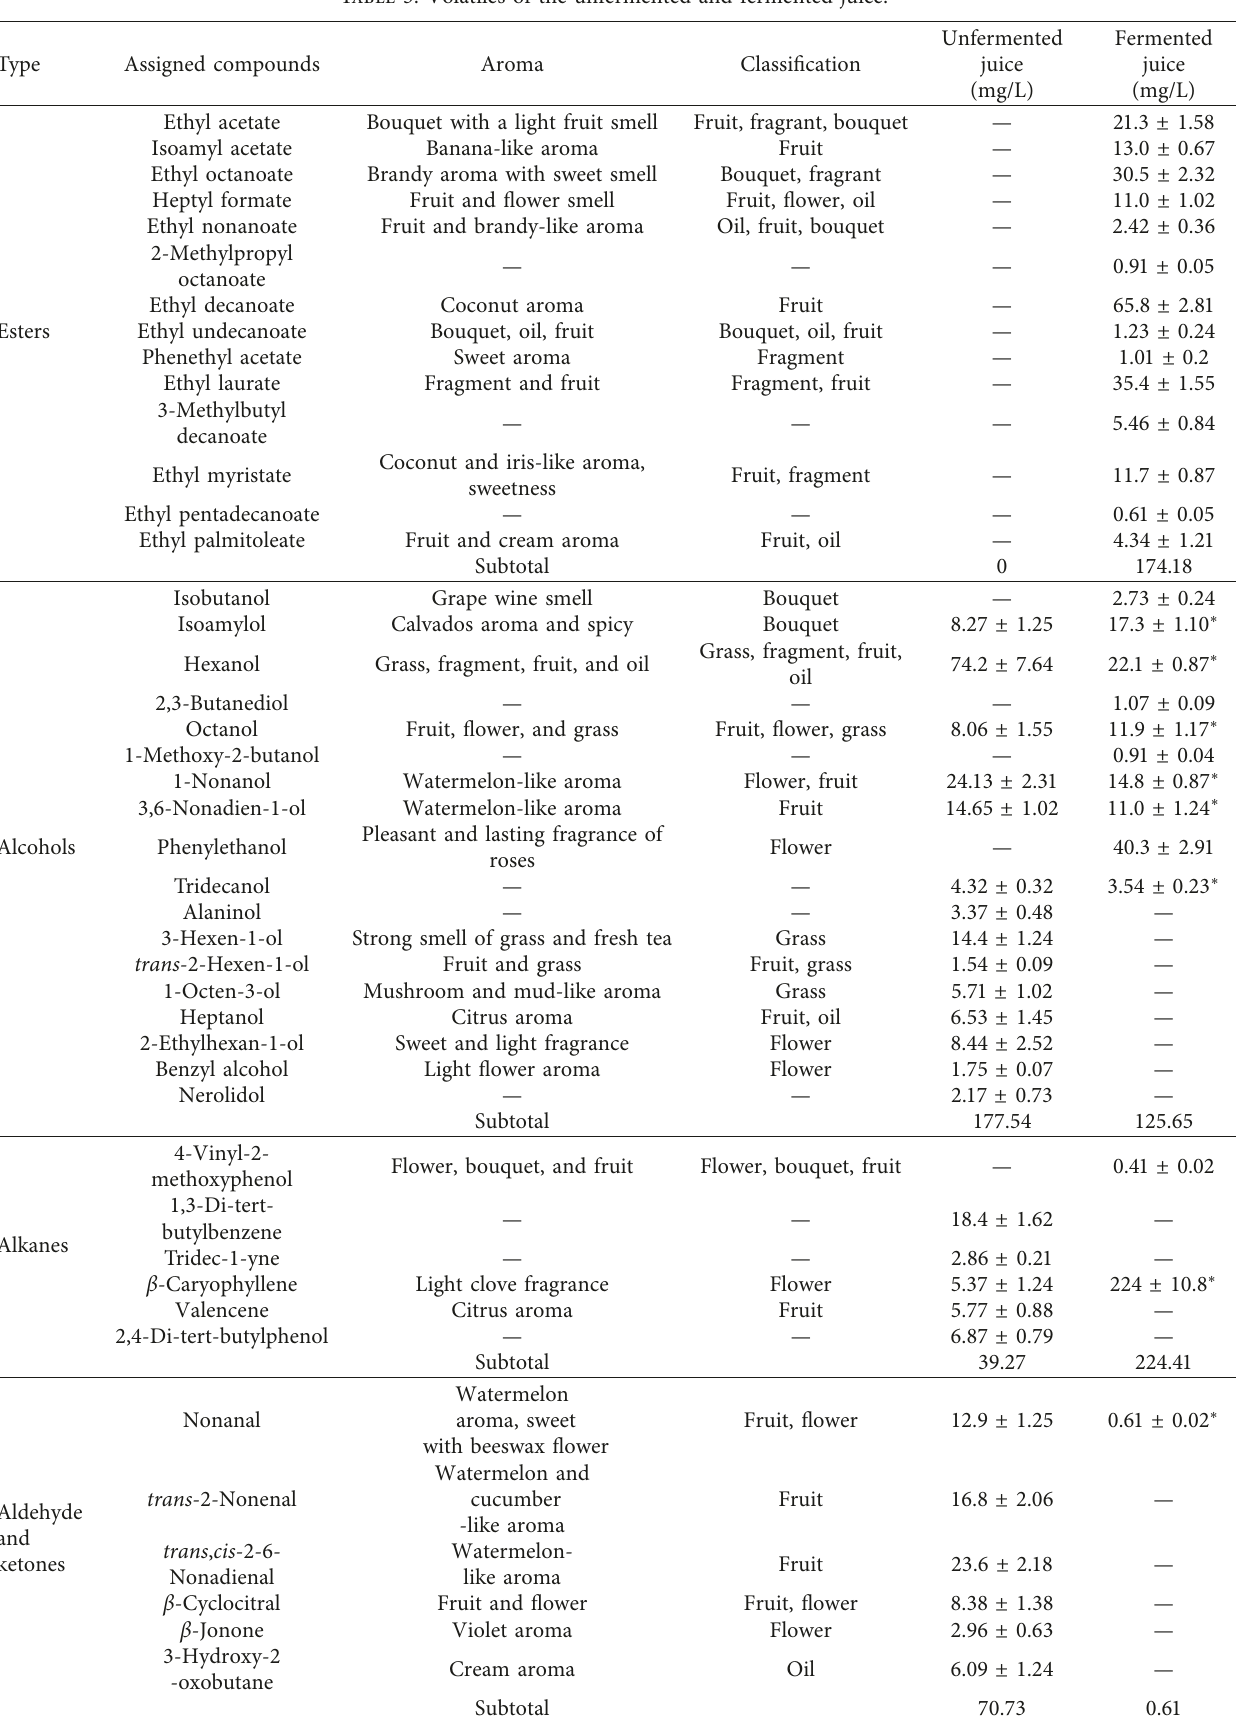
Table 3: Volatiles of the unfermented and fermented